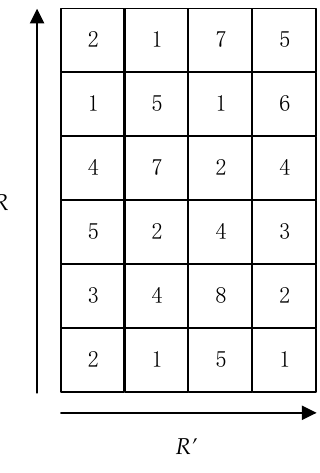
Figure 5. Similarity matrix .